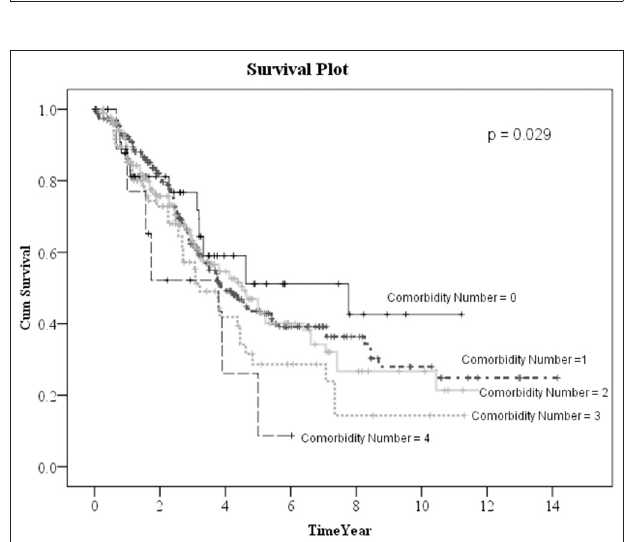
FIGURE 4 | The survival pot of PD catheters in diabetes patients with HbA1C < 7 and ≥ 7. PD, peritoneal dialysis.